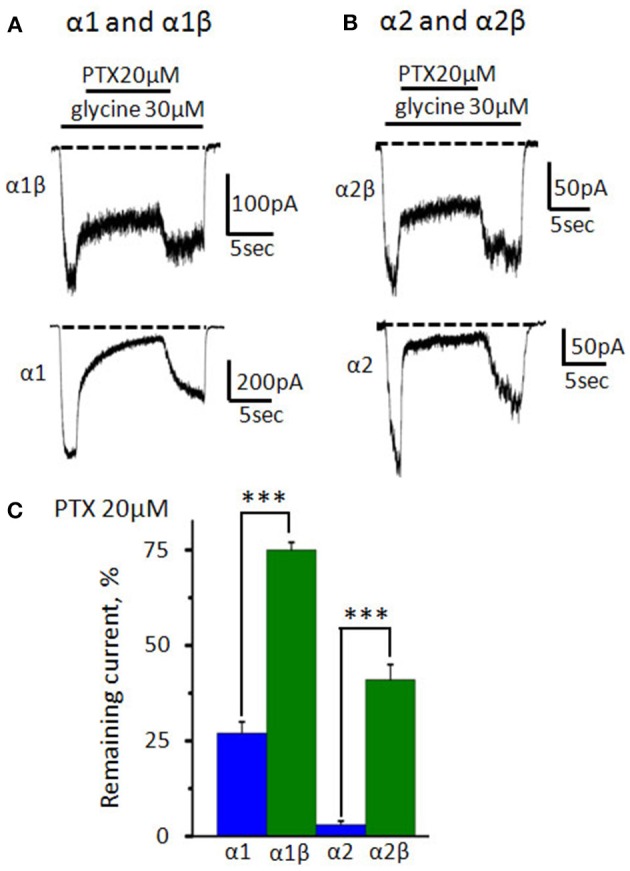
Inhibition of homomeric and heteromeric receptors by picrotoxin. (A) The action of PTX (20 μM) on currents mediated by α1β (upper trace) and α1 GlyRs (bottom trace). The currents were evoked by 30 μM of glycine; Vhold = −30 mV. (B) The action of PTX (20 μM) on currents mediated by α2β (upper trace) and α2GlyRs (bottom trace). The currents were evoked by 30 μM of glycine; Vhold = −30 mV. For clarity, dotted lines show the current levels in the absence of the agonist. (C) Percentage of the remained current from control under application of PTX (20 μM) for α1 (n = 12), α1β (n = 15), α2 (n = 9), and α2β (n = 7) GlyRs (homomeric receptors—blue, heteromeric—green). Data represented as mean ± SEM, ***p < 0.001, unpaired t-test.